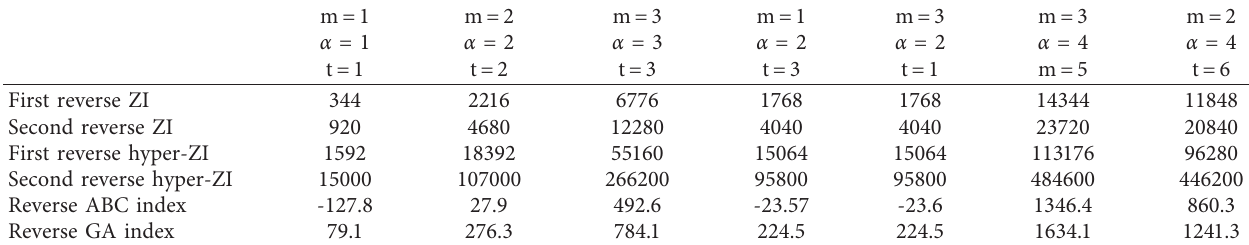
2 [ m , α , t ] at different